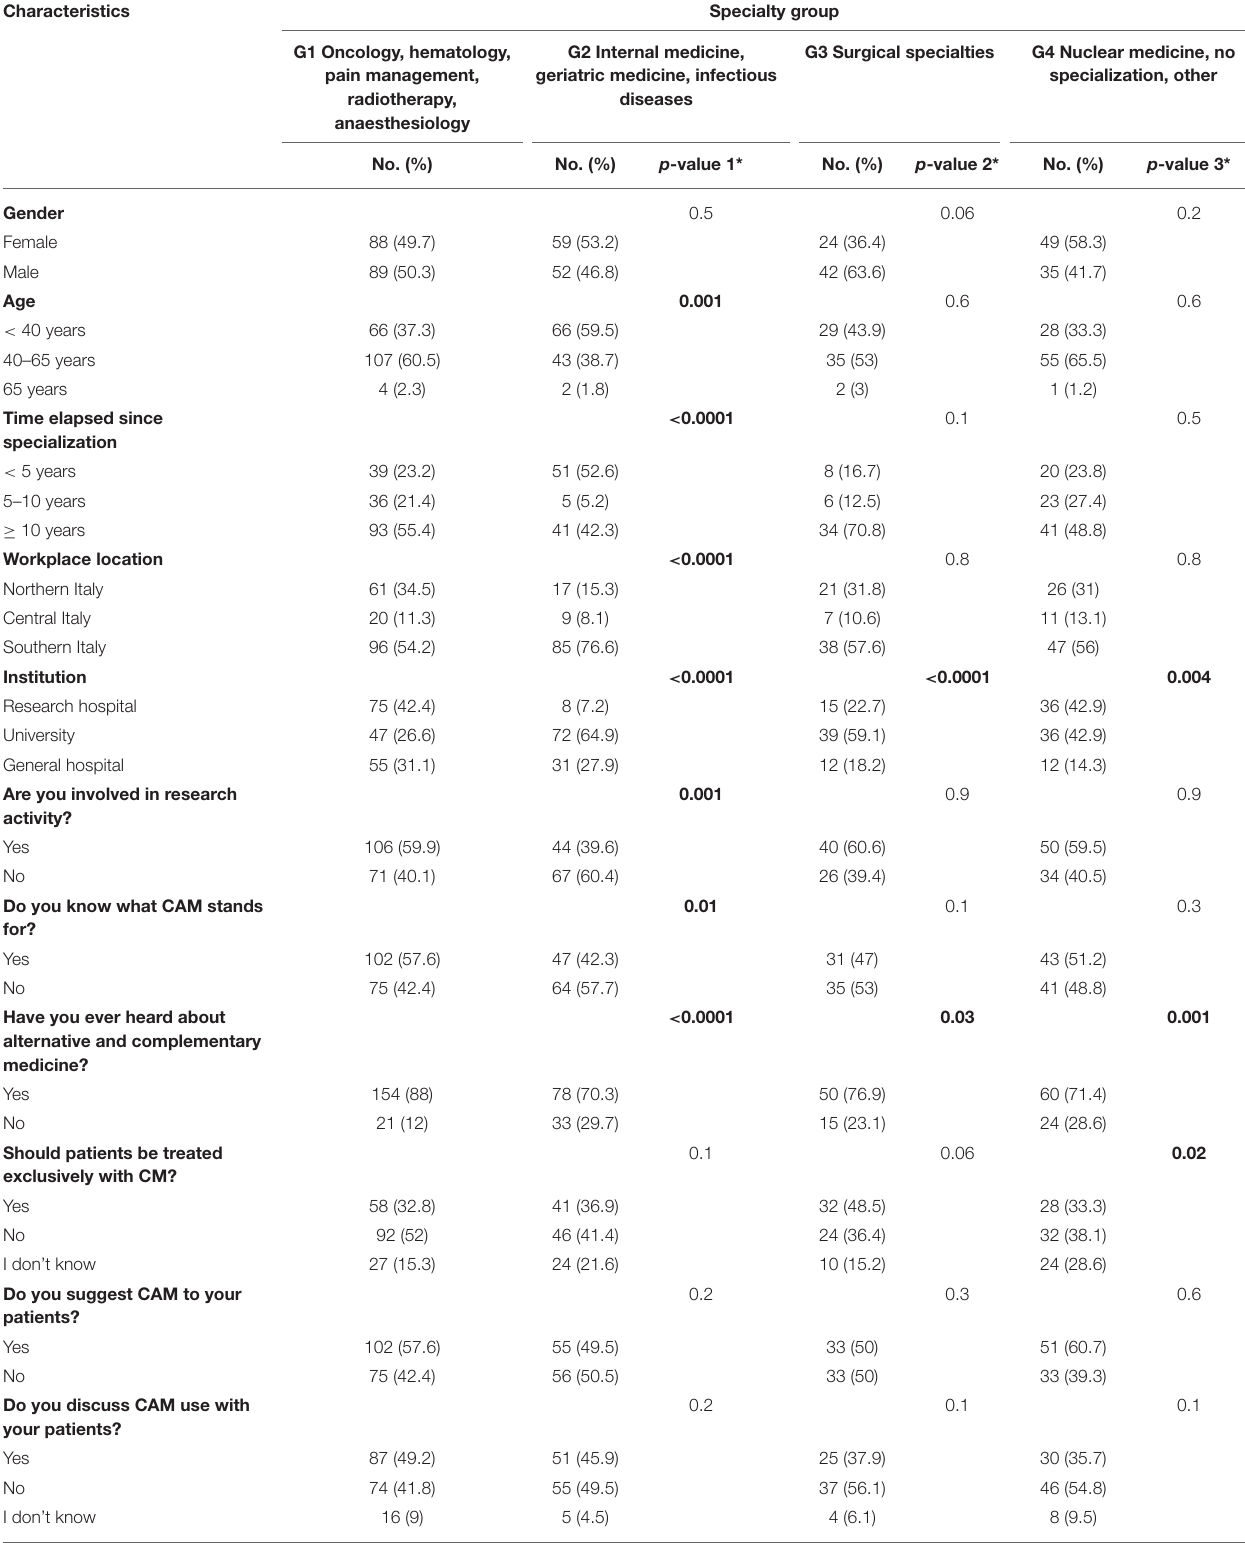
TABLE 4 | Physicians’ characteristics and their CAM knowledge according to their